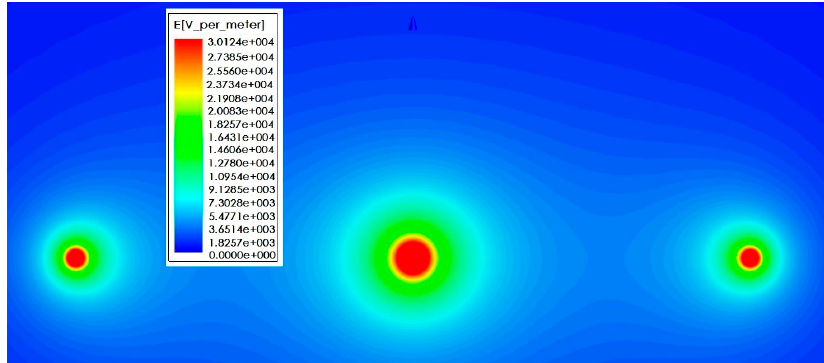
Figure 15. Electric field distribution without sensor.